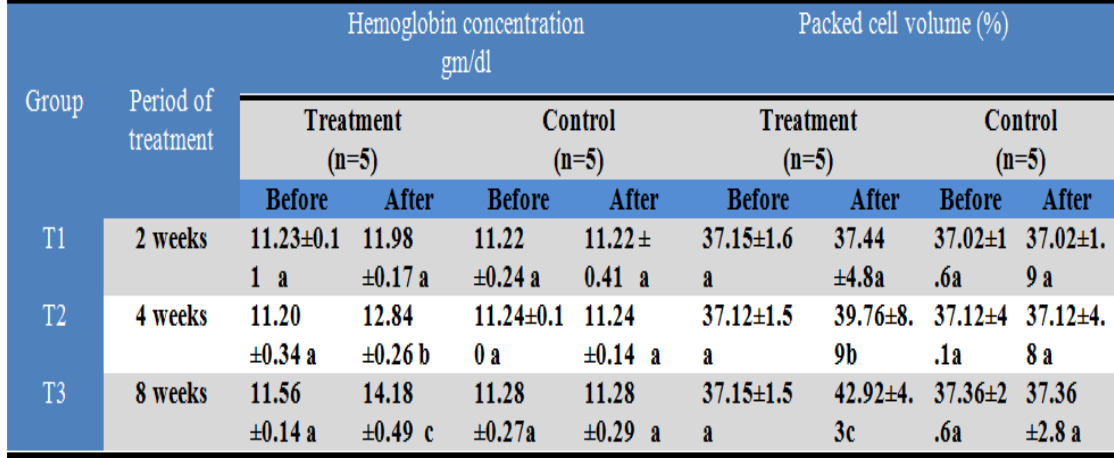
Values are expressed as means ±